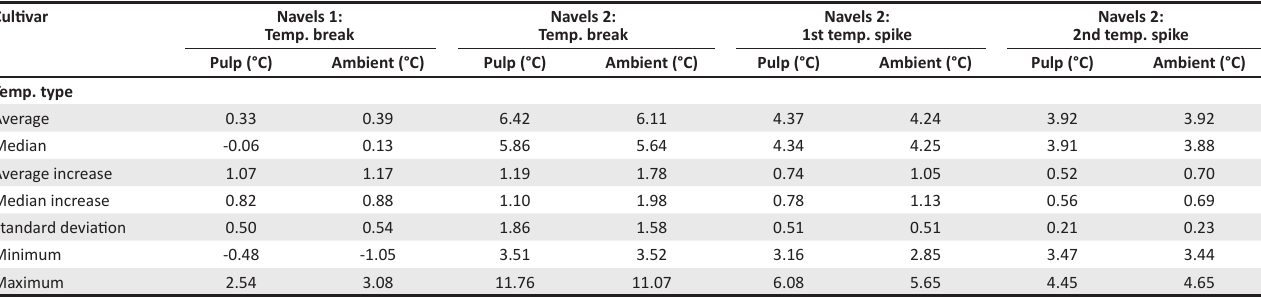
TABLE 4: Temperature dispersion of navels loads one and two: Cold storage. Cultivar Navels 1: